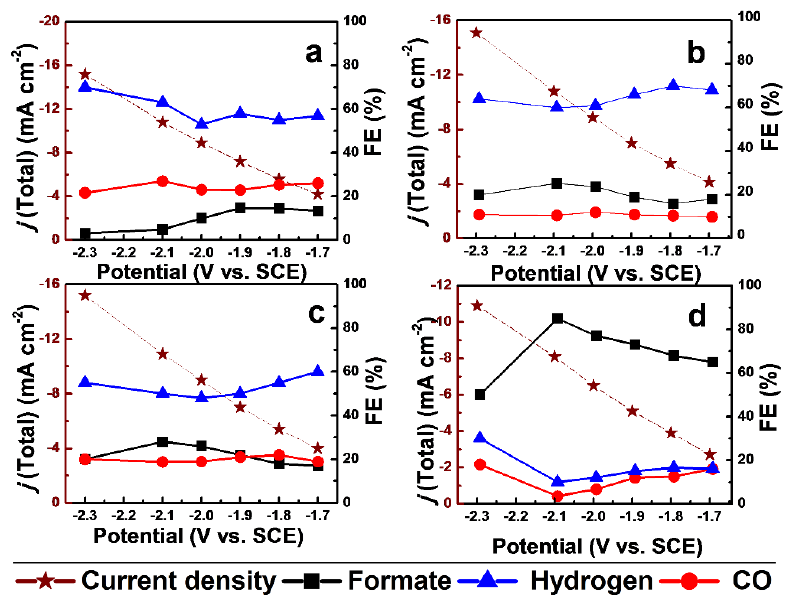
Figure 5. Catalytic activities of Pd and Pd-amalgam catalysts during the CO 2 reduction at various constant potentials in a CO 2 saturated 0.1 M KHCO 3 solution ( a ) Faradaic efficiencies of HCOO − , CO and H 2 at Pd ( b ) Faradaic efficiencies of HCOO − , CO and H 2 at PdHg100, ( c ) Faradaic efficiencies of HCOO − , CO and H 2 at PdHg200. ( d ) Faradaic efficiencies of HCOO − , CO and H 2 at PdHg800.